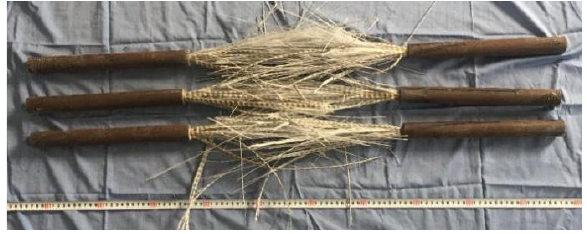
Figure 5: Tensile failure mode of GFRP2 bars